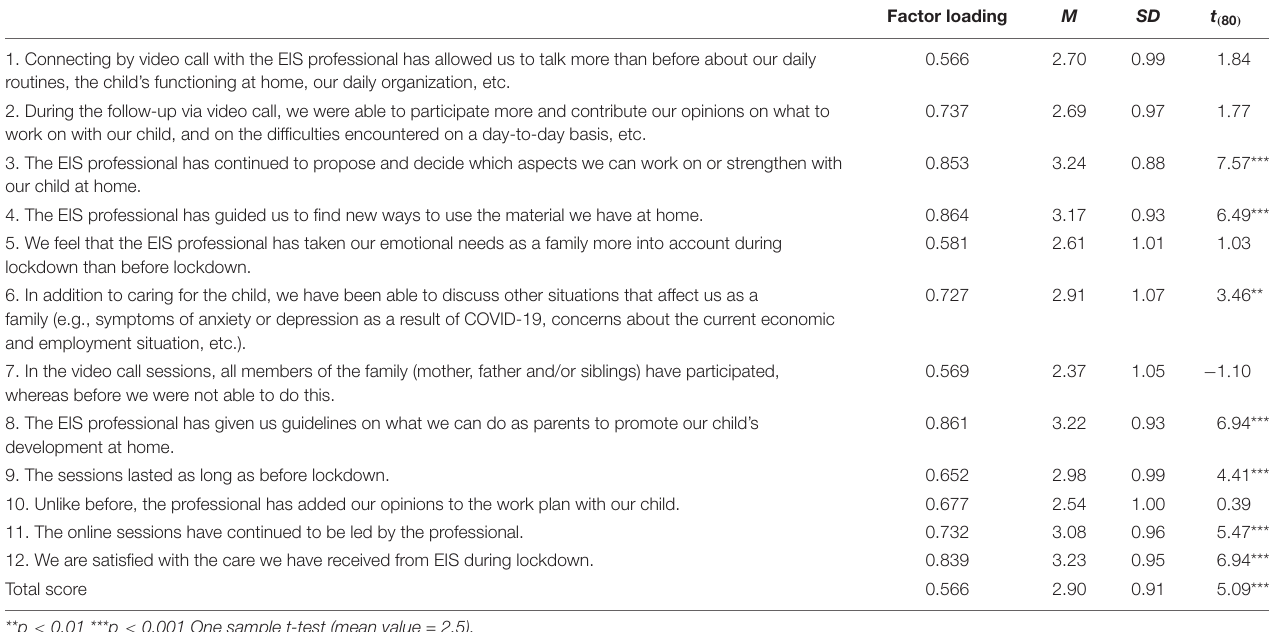
TABLE 3 | Exploratory factor analysis and descriptive statistics for the questionnaire answered by the families ( n = 81).